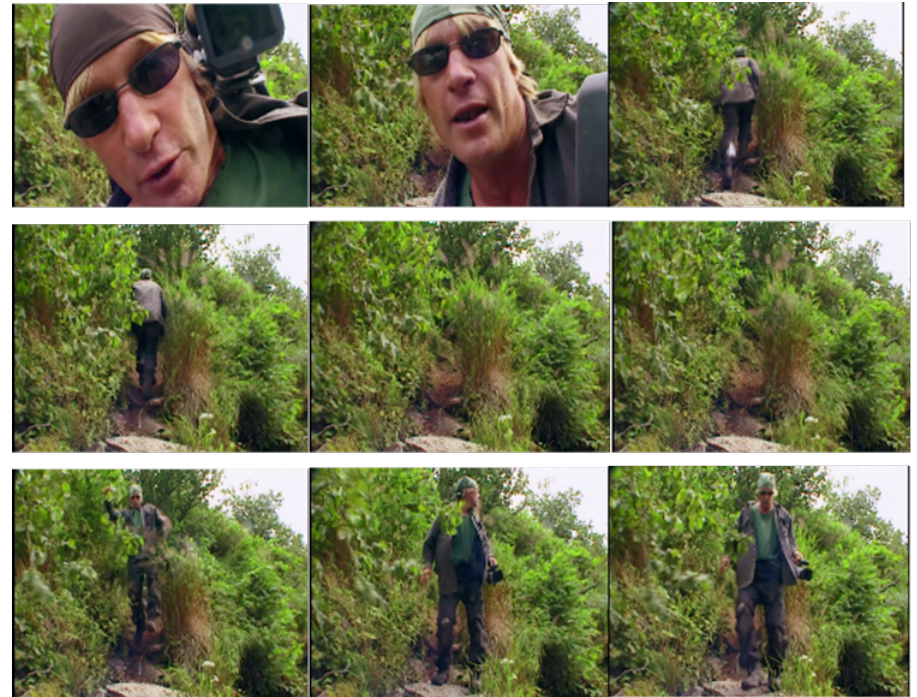
Figure 3 . The ecstatic beauty of Treadwell’s frames alternating his wandering figure and the surrounding